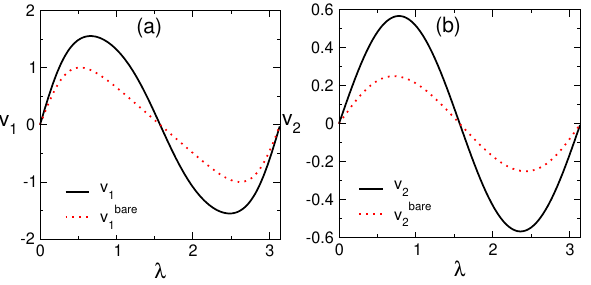
Figure 5: Comparison between bare and dressed velocities. The results are for the thermal density matrix (31) with β = 0.5, β h = 0.25 and ∆ = 1.5. The continuous line and the dotted line are the dressed and the bare velocities, respectively. Panel (a) and (b) show the velocities for the unbound and the two-particle bound states. Note that non monotonicity of the velocities implies that for some α , β , λ , µ one has − v bare ) (cid:54) = sign ( v − v ) sign ( v bare α , λ β , µ α , λ β , µ